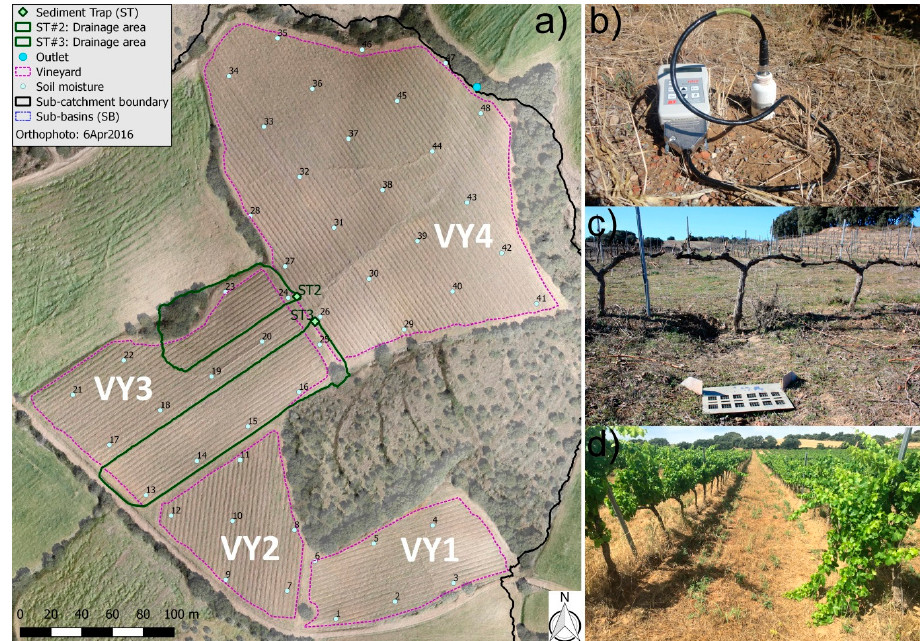
Figure 2. Location of the topsoil water content (TSWC) measurement points in the four vineyards of “Los Oncenos” sub-catchment ( a ). Photos of the device to measure TSWC ( b ), of the sediment trap #2 with the upslope contributing area ( c ) (taken on 12 February 2018) and of the cover crop in the contributing area of the sediment trap #3 after the mowing pass in late May 2017 ( d ) (taken on 27 June